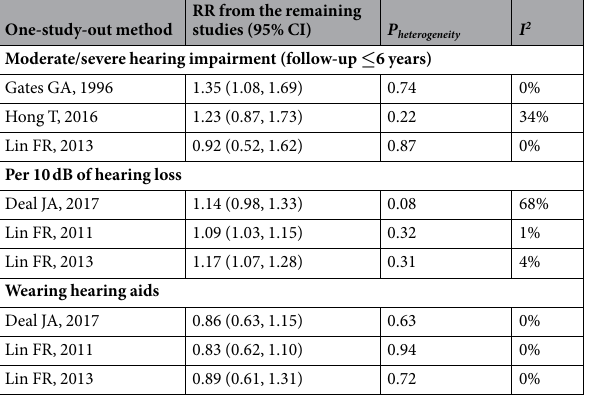
Table 4. Sensitivity analyses of included studies. Abbreviations: CI = confidence interval, dB = decibels, RR = relative